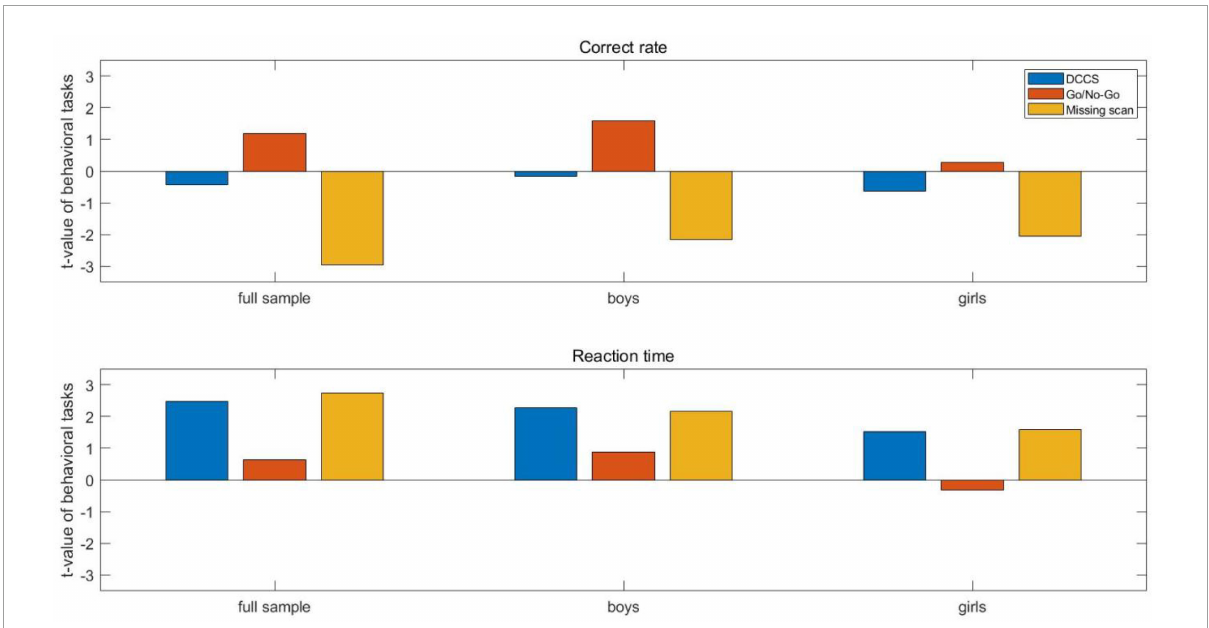
FIGURE5 Bar chart for the behavioral results of the three tasks before and after intervention for the full sample, boys’ group, and girls’ group, respectively.